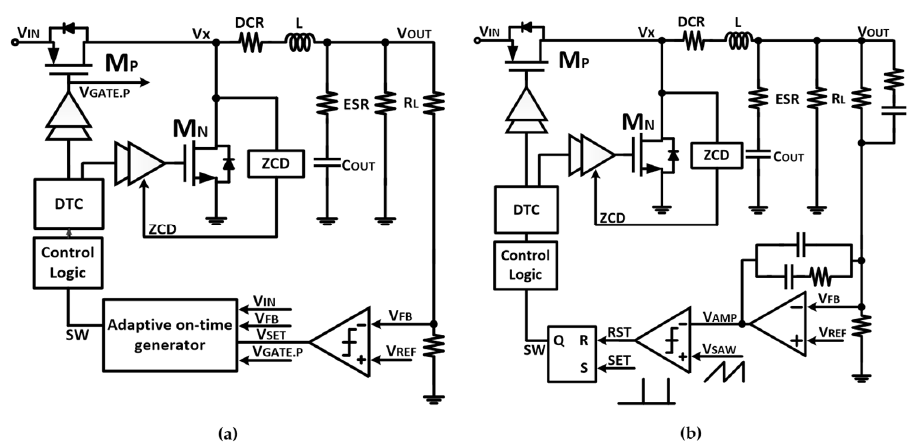
Figure 1. Conventional DC-DC buck converters: ( a ) adaptive on-time controlled pulse frequency modulation (PFM) converter and ( b ) voltage-mode pulse width modulation (PWM) converter.